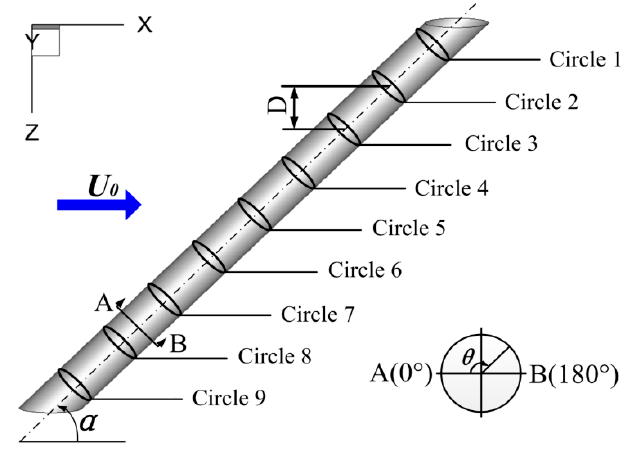
Figure 10. Sampling scheme of pressure distribution on cylinder wall.